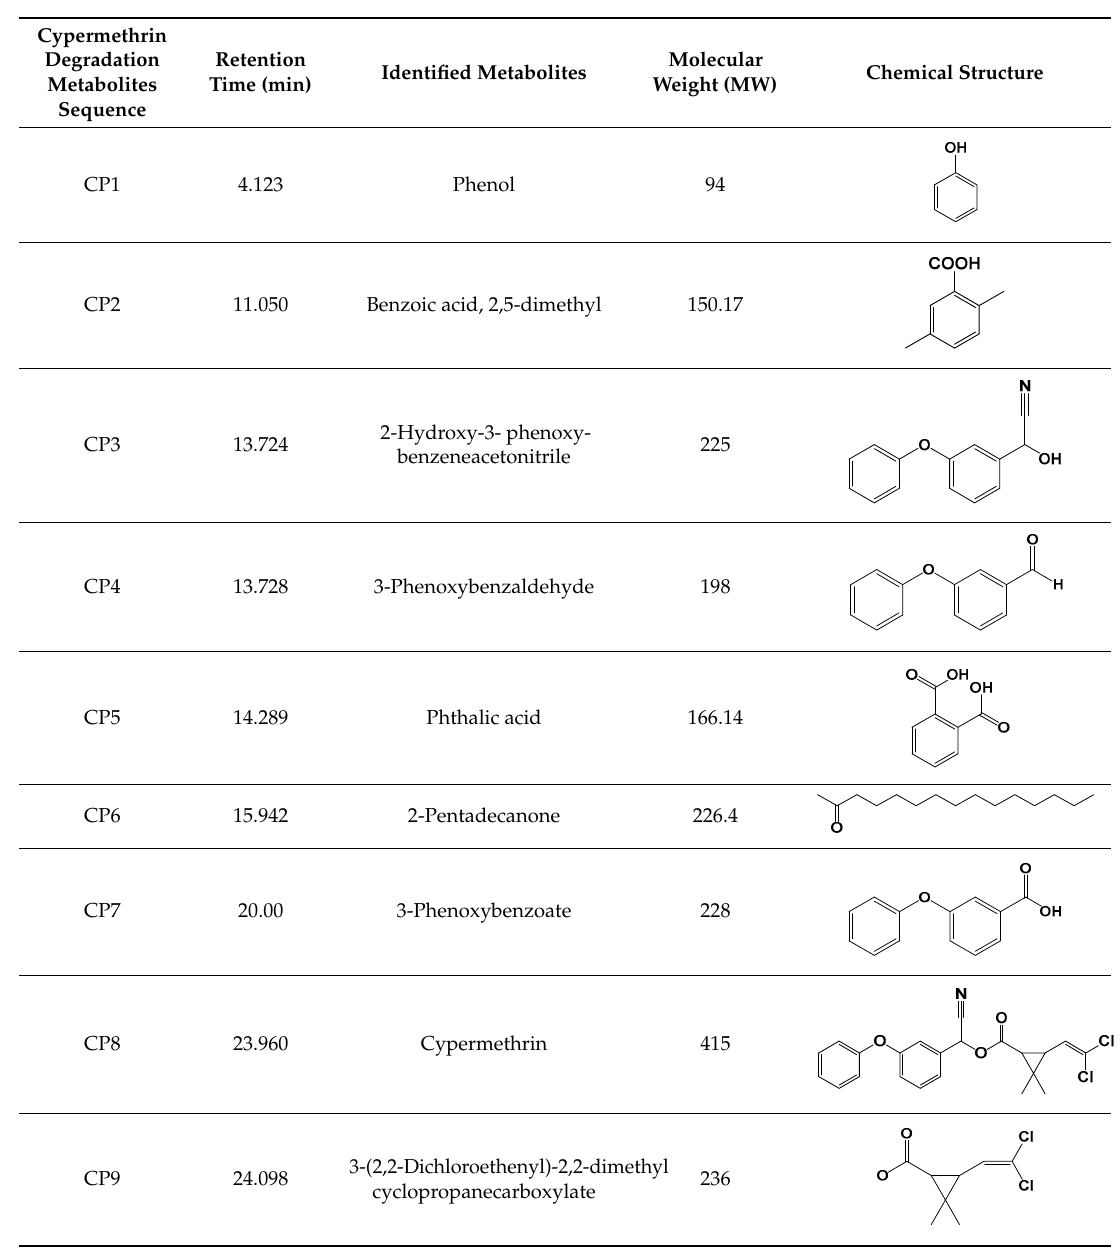
pathway. Table 3. Gas chromatography–mass spectrometry (GC-MS) analysis of the cypermethrin degradation metabolites. Table 3. Gas chromatography–mass spectrometry (GC-MS) analysis of the cypermethrin degradation Table 3. Gas chromatography–mass spectrometry (GC-MS) analysis of the cypermethrin degradation metabolites. metabolites. Table 3. Gas chromatography–mass spectrometry (GC-MS) analysis of the cypermethrin degradation Identified metabolites. Weight Table 3. Gas chromatography–mass spectrometry (GC-MS) analysis of the cypermethrin degradation Table 3. Gas chromatography–mass spectrometry (GC-MS) analysis of the cypermethrin degradation metabolites. Table 3. Gas chromatography–mass spectrometry (GC-MS) analysis of the cypermethrin metabolites. degradation metabolites.